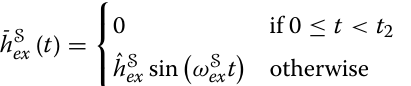
= 2 π · 6 . 2684 s − 1 ex